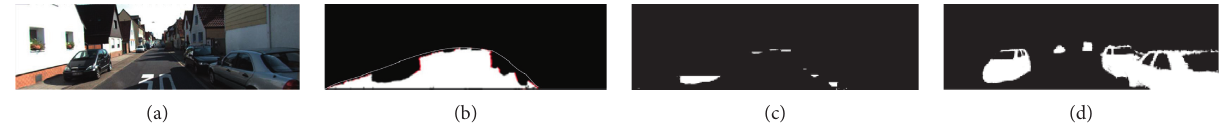
Figure 6: The detection algorithm of vehicle on the road. (a) Original image. (b) Road periphery envelope. (c) Vehicle source point. (d) Detection